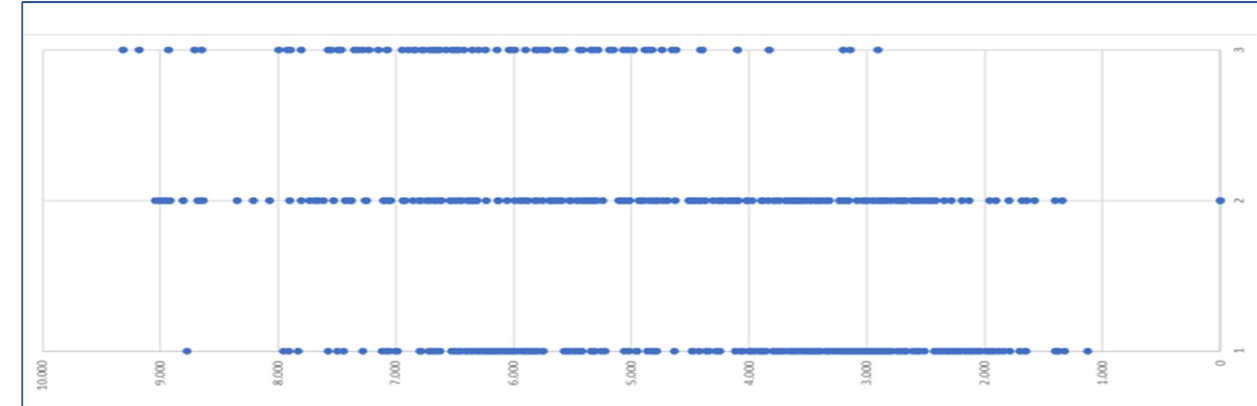
Figure 1. Distances within each of the three clusters.